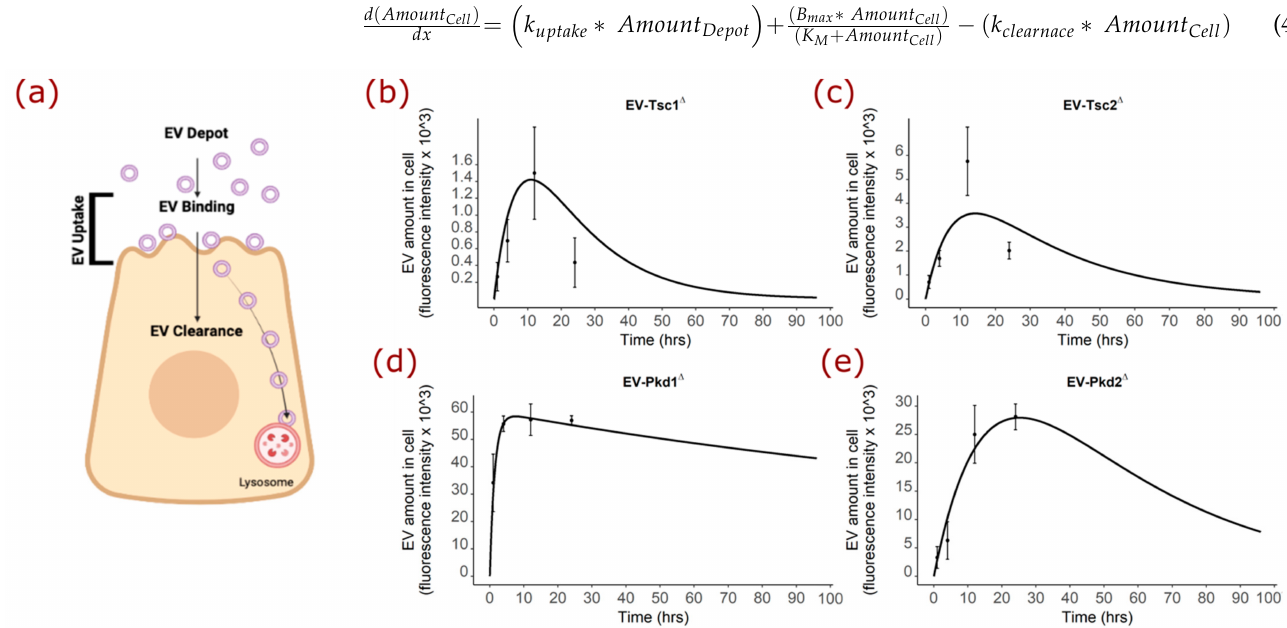
Figure 6. Mathematical modeling of EV-cellular interaction. ( a ) Cartoon depicting the components and phases of fluorescently labeled EV interaction with the renal cell. ( b ) Modeling of experimentally derived time course data for EVs from mIMCD3 cells with disrupted Tsc1 , Tsc2 , Pkd1 , and Pkd2 genes. ( c ) Modeling data graphed over time for EVs from mIMCD3 cells with disrupted Tsc2 . ( d ) Modeling data graphed over time for EVs from mIMCD3 cells with disrupted Pkd1 . ( e ) Modeling data graphed over time for EVs from mIMCD3 cells with disrupted Pkd2